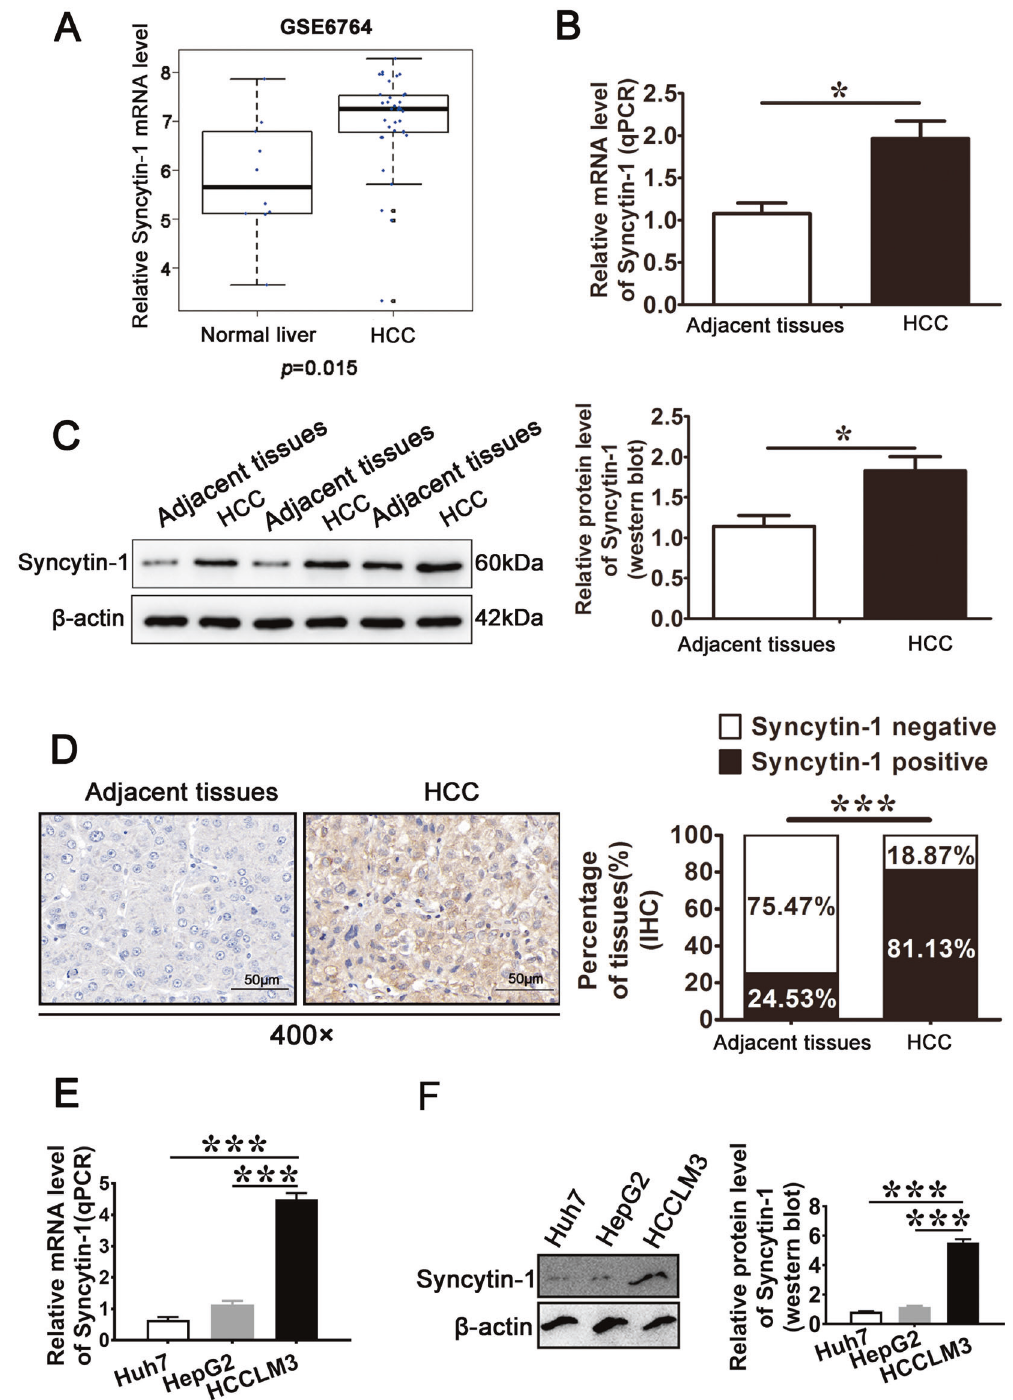
Fig. 1 Syncytin-1 is highly expressed in HCC tissues and cell lines. a Data from GSE6764 was used to analyze the mRNA level of Syncytin-1 in HCC and normal liver. b The mRNA level of Syncytin-1 was determined by quantitative real-time PCR (qPCR) in HCC and adjacent tissues. c Syncitin-1 protein levels in 33 pairs of HCC and adjacent tissues were assessed using western blotting. d 53 paired of formalin- fi xed HCC specimens and 50 formalin- fi xed HCC without adjacent tissues (totally 103) were obtained to detect Syncytin-1 expression by IHC. Representative images are shown (magni fi cation, ×400). e and f Syncytin-1 mRNA and protein levels in several HCC cell lines were investigated using qPCR ( e ) and western blotting ( f ), respectively. Each bar represents results from three independent experiments. * p < 0.05, *** p < Knockdown of Syncytin-1 expression in HCCLM3 cells by role of an oncogene on cell proliferation and migration in HCC transfecting with pSilencer-shSyncytin-1 con fi rmed the above [29, 30], were used. As shown in Fig. 3a, there was a time- result (Supplementary Fig. S1a). Correspondingly, the results of dependent increase of cell viability in Syncytin-1-transfected cell cycle analysis also veri fi ed that Syncytin-1 increased the cell NIH3T3 cells using a real-time cell analysis (RTCA) assay.